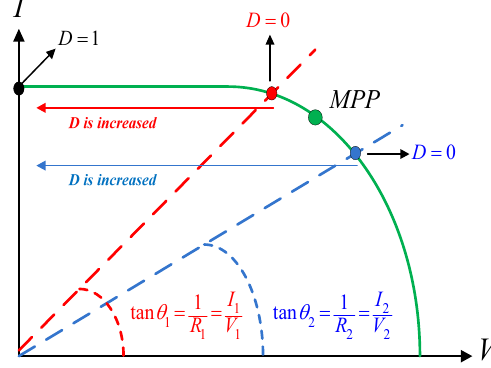
Figure 3. The variation of MPP by changing the duty cycle in the I ‐ V curve.